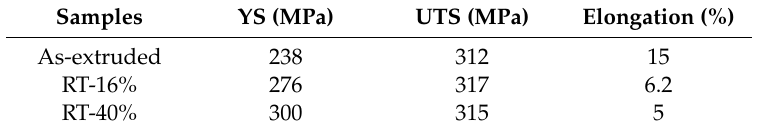
Figure 2. ( a ) Engineering tensile stress and strain curves of AlN / Al nanocomposites with di ff erent rolling reductions at room temperature (RT); ( b ) the obtained strain hardening rates of the nanocomposites before and after rolling. Table 1. Tensile properties of AlN / Al composites with di ff erent rolling reductions at